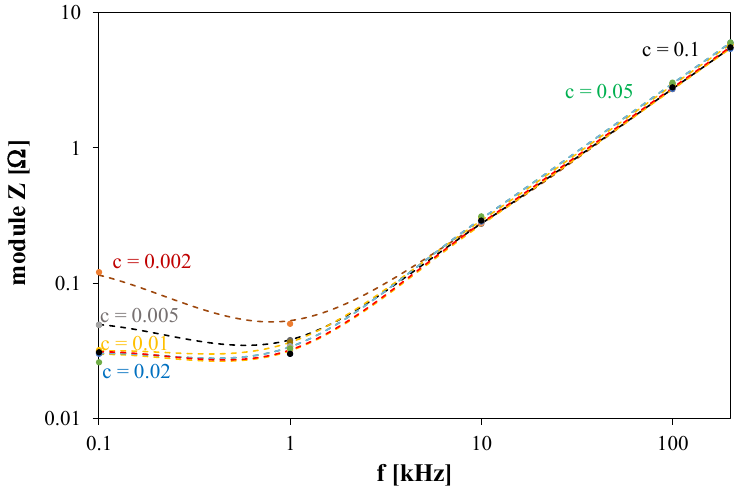
Figure 8. Calculated and measured dependence of the electrolyzer impedance module on frequency.